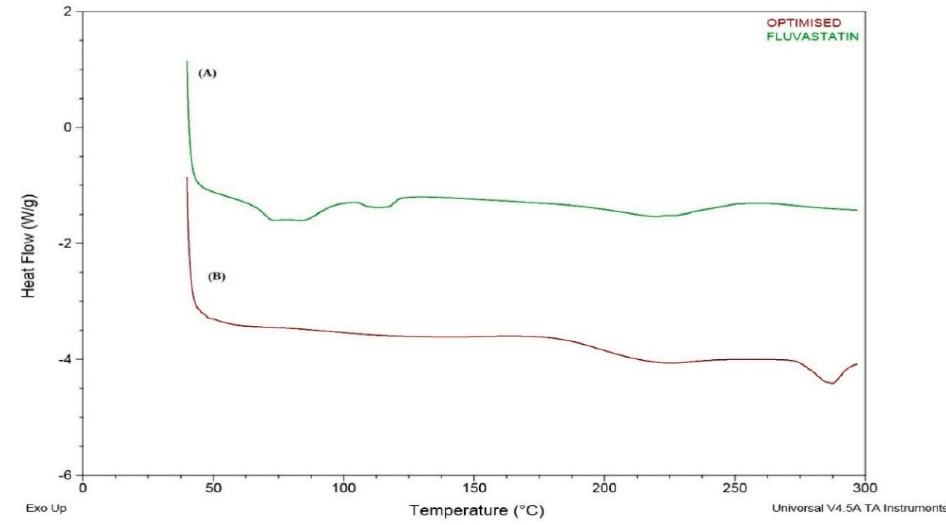
Figure 7. ( A ) Pure FLV, ( B ) optimized formulation thermograms.